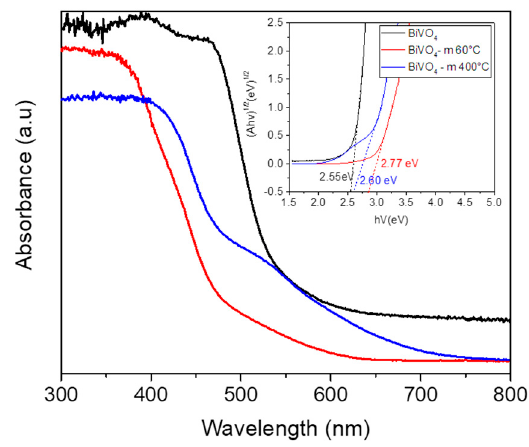
Figure 7. UV-Vis diffuse reflectance spectra of BiVO 4 microspheres.